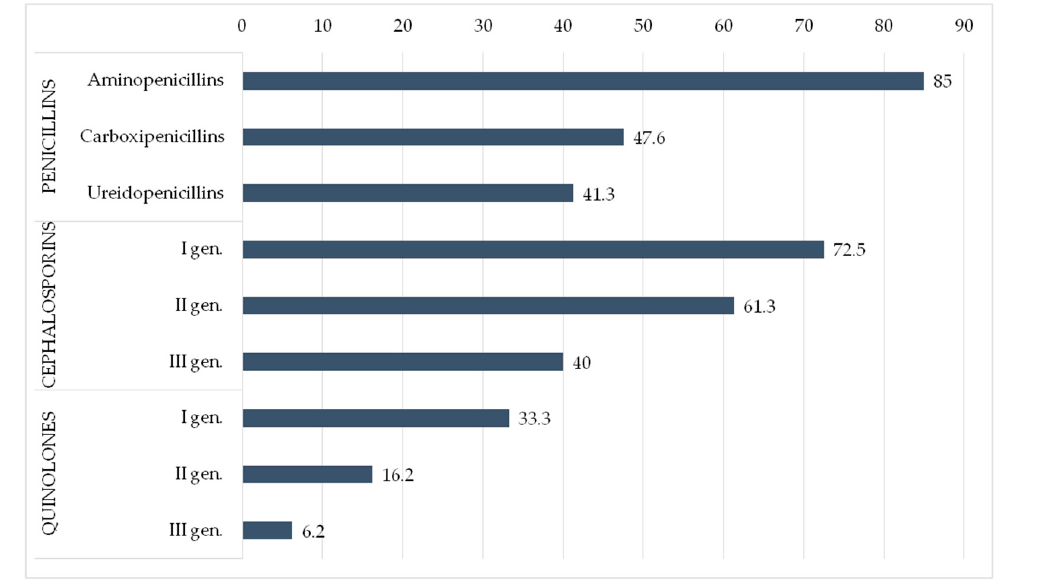
Figure 6. Percentage resistance to the different classes of penicillins, cephalosporins, and quin- olones.